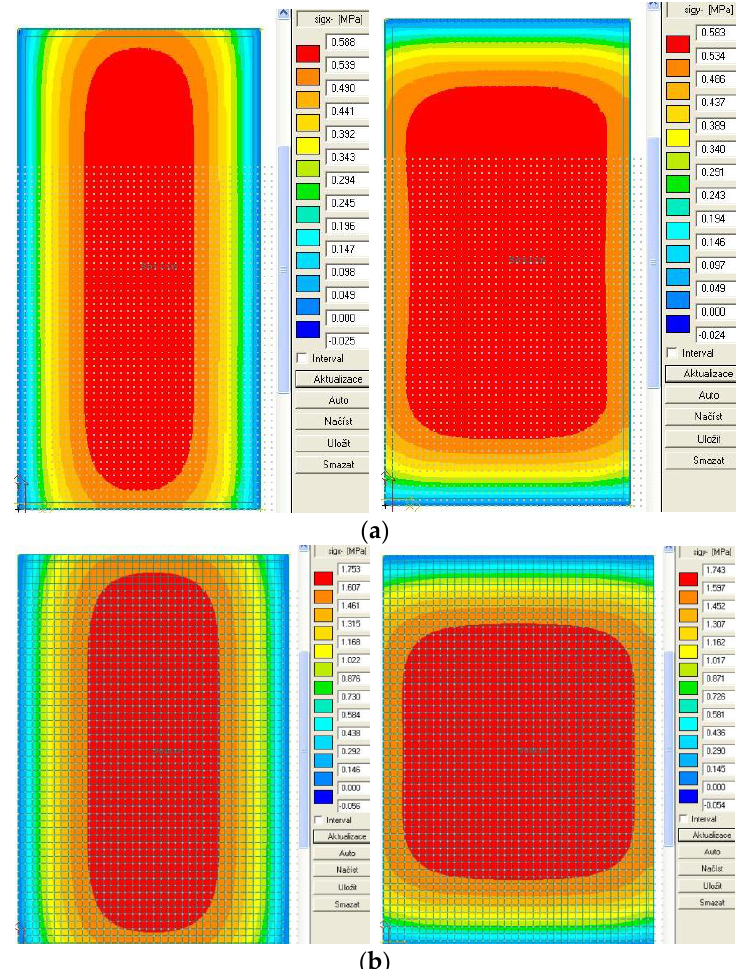
Figure 10. Stress distributions (σ x , σ y ) in concrete slabs: ( a ) temperature gradient 0.3 C per mm (K INT); and ( b ) temperature gradient 0.1 C per mm (K EX).